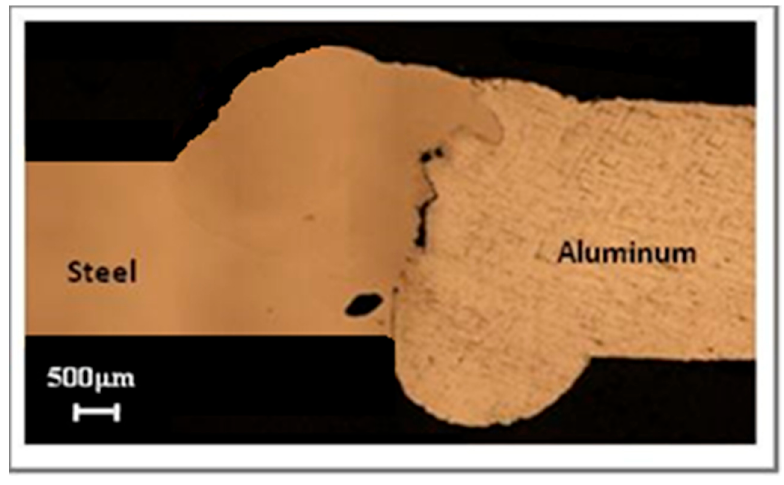
Figure 17. Optical macrograph of cross section by hybrid laser-MIG welding.